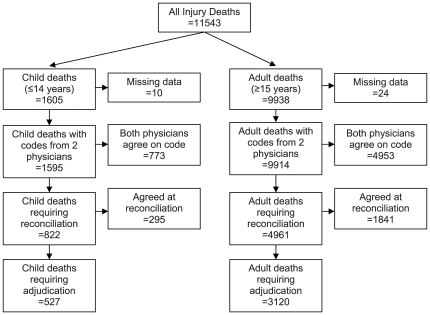
Flow diagram of Million Death Study injury deaths.